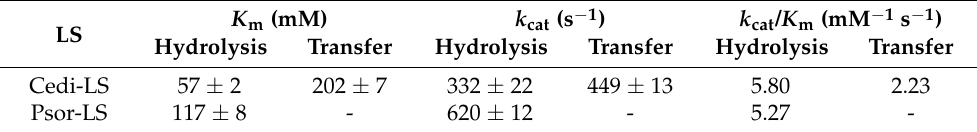
Table 2. Kinetic parameters of Cedi-LS and